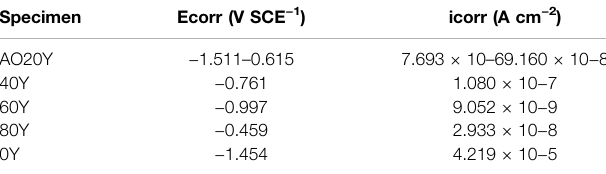
TABLE 4 | Electrochemical parameters of different